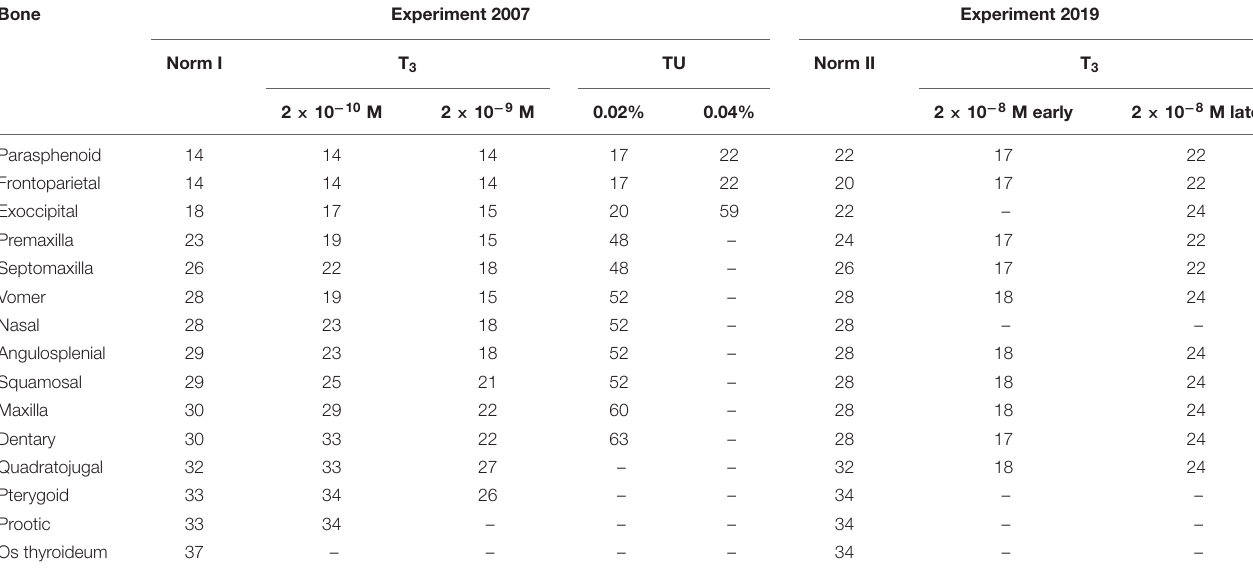
TABLE 3 | Timing (the earliest registration in dph) of cranial bones appearance in larval Bombina variegata under different experimental regimes. Bone Experiment